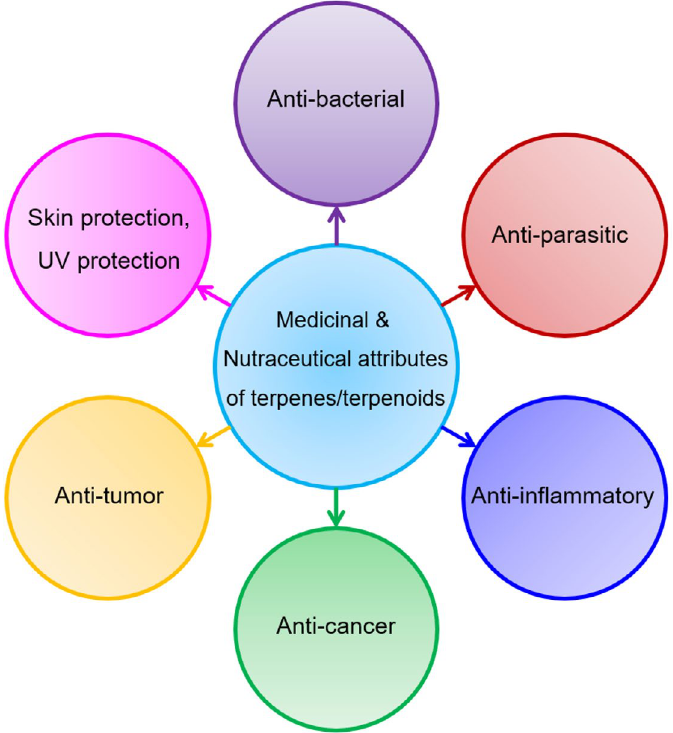
Fig. 5. Medicinal and nutraceutical applications of